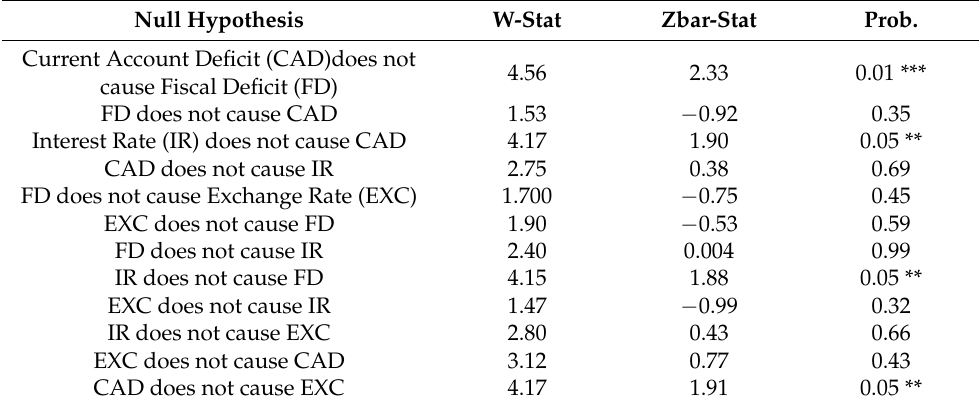
Table 7. Dumitrescu and Hurlin (DH) Granger Causality